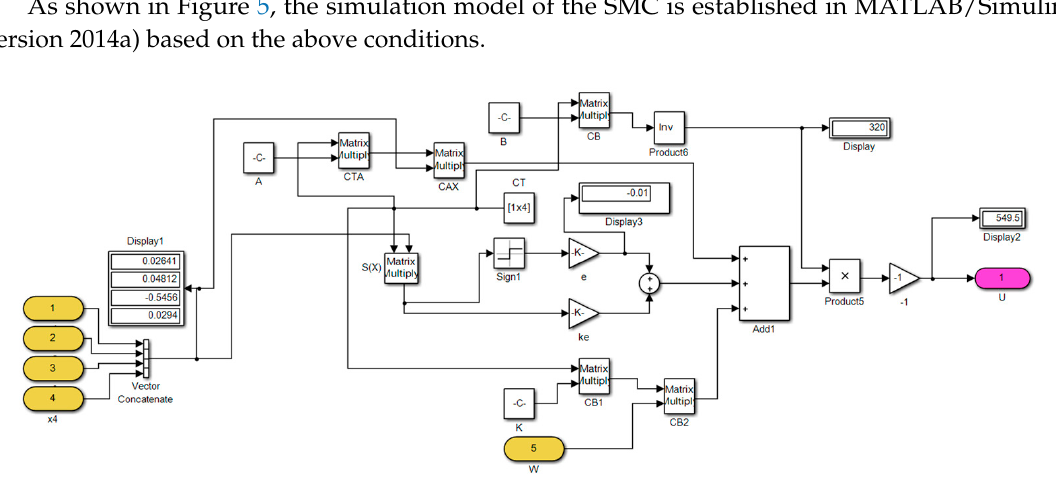
Figure 5. Simulation model of SMC in MATALB/Simulink.